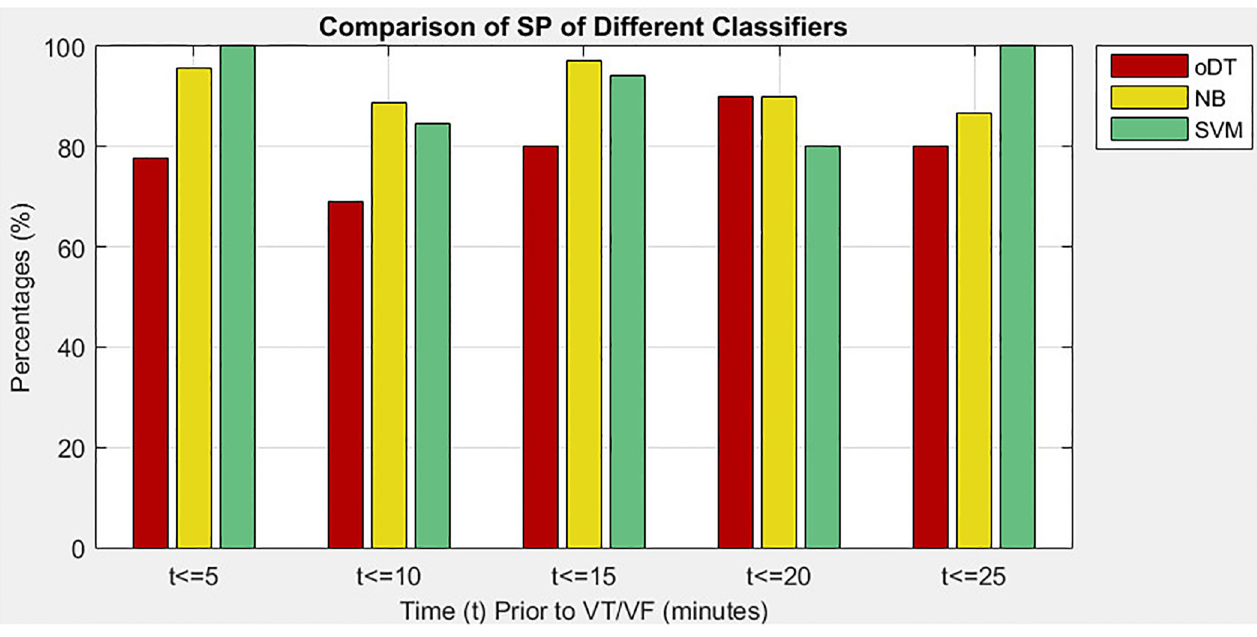
Fig 7. Comparison of SP among oDT, NB and